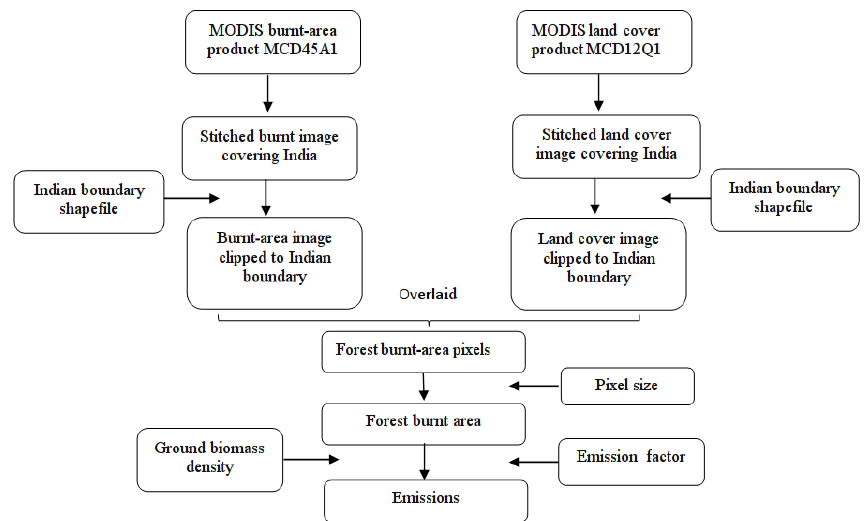
Figure 3. Flow chart for the calculation of forest fire emissions based on MODIS